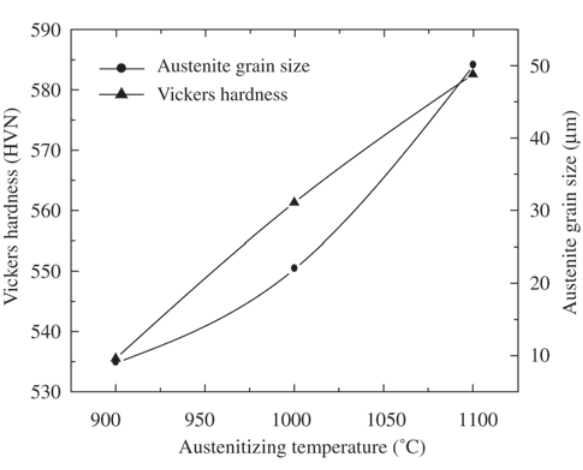
Figure 6. Evolution of hardness and ultimate tensile strength with the martensite volume fraction.